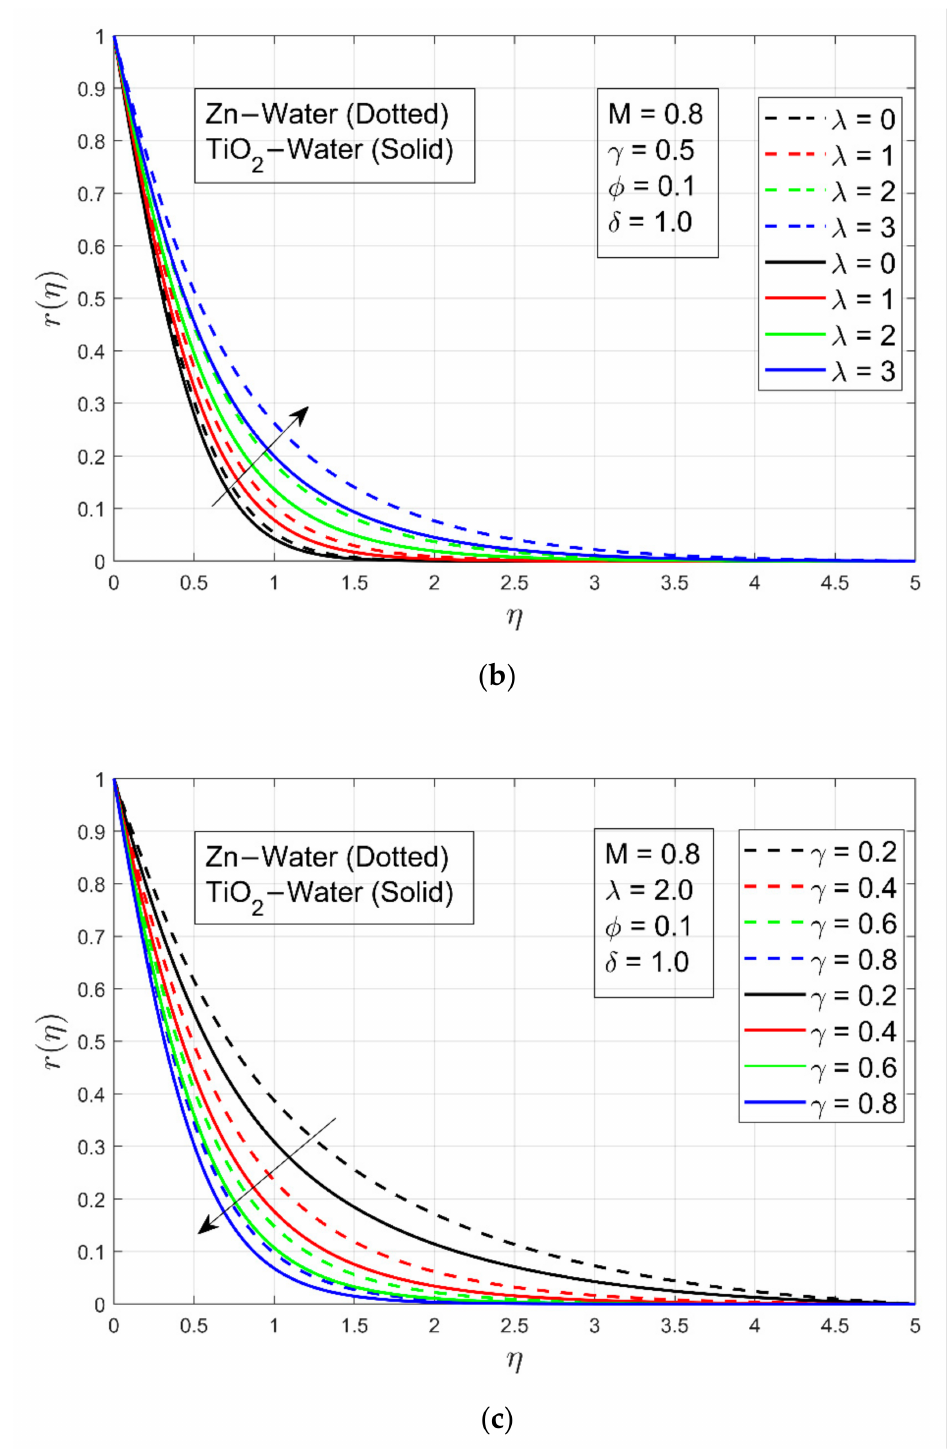
Figure 5. ( a ) The influence of M on r ( η ) , ( b ) the influence of λ on r ( η ) , and ( c ) the influence of γ on r ( η )